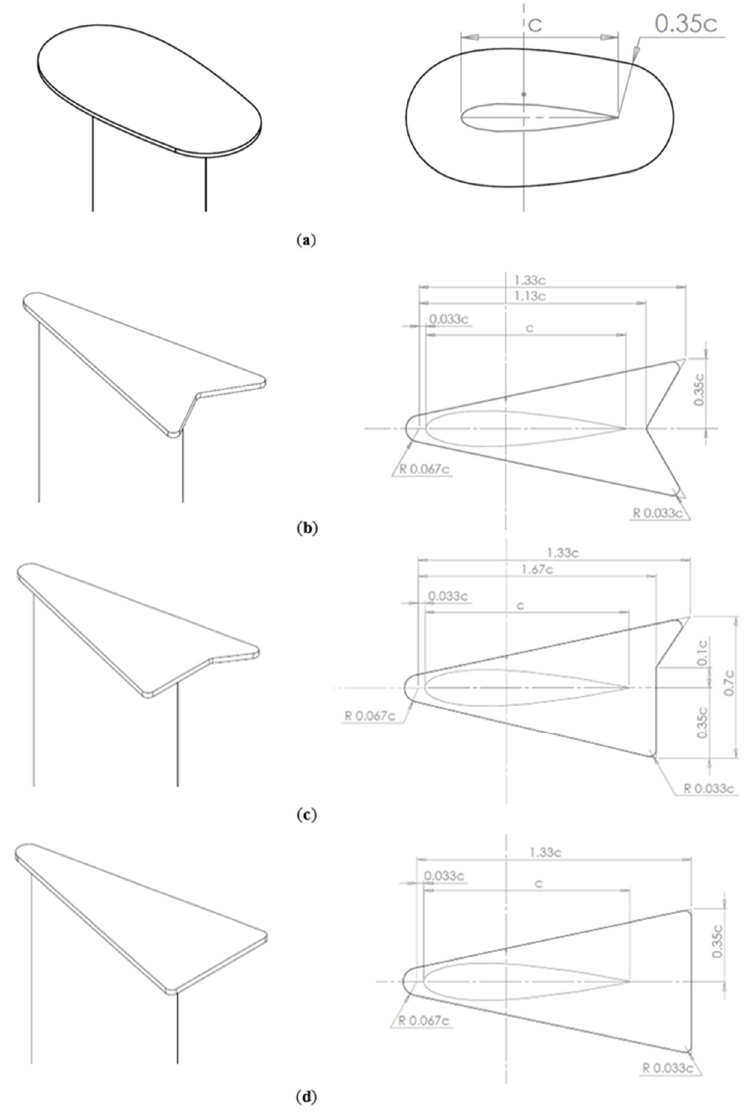
Figure 2. Endplate geometries: ( a ) 0.35 c offset endplate; ( b ) symmetric V endplate; ( c ) asymmetric endplate; ( d ) triangular endplate.